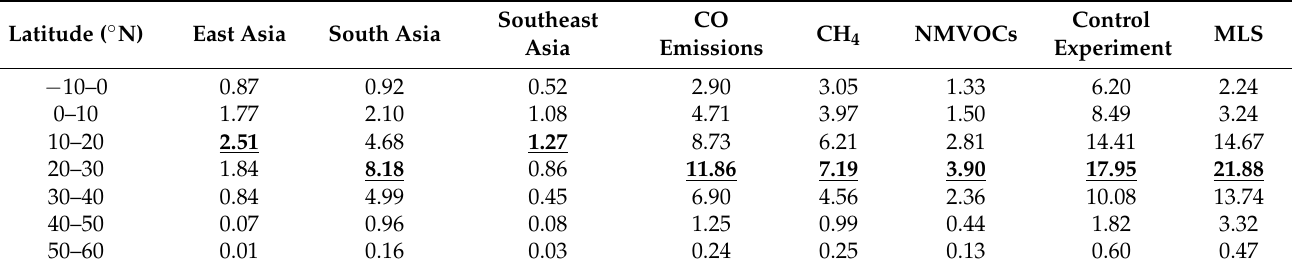
Table 1. Differences in the CO concentration in two longitude ranges. Units: